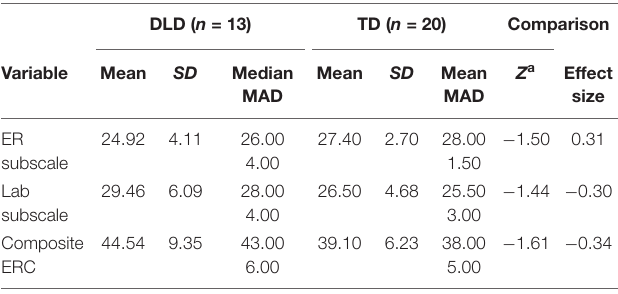
TABLE 3 | Emotion regulation for children with Developmental Language Disorder (DLD) and typically developing (TD) children measured at wave 2 (Study 1). DLD ( n = 13)